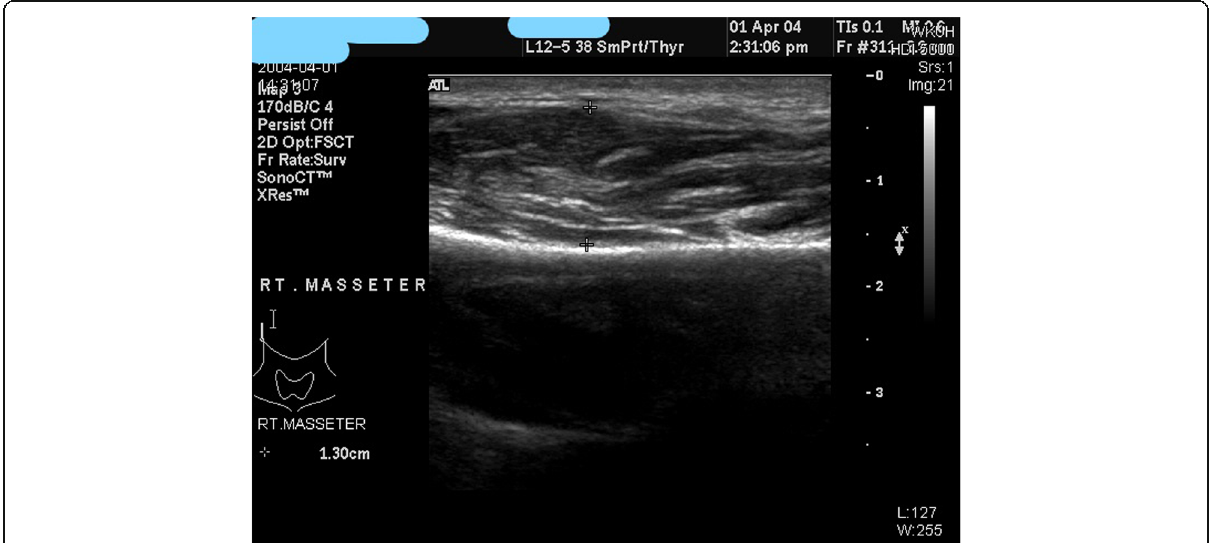
Fig. 13 Diagnosing method for square jaw: sonograph. With the help of Panorama, skull PA, and sonograph of masseter muscle, you can identify the skeletal portion and patterns of muscle hypertrophy, and able to decide which one to use: surgical intervention or botulinum toxin injection